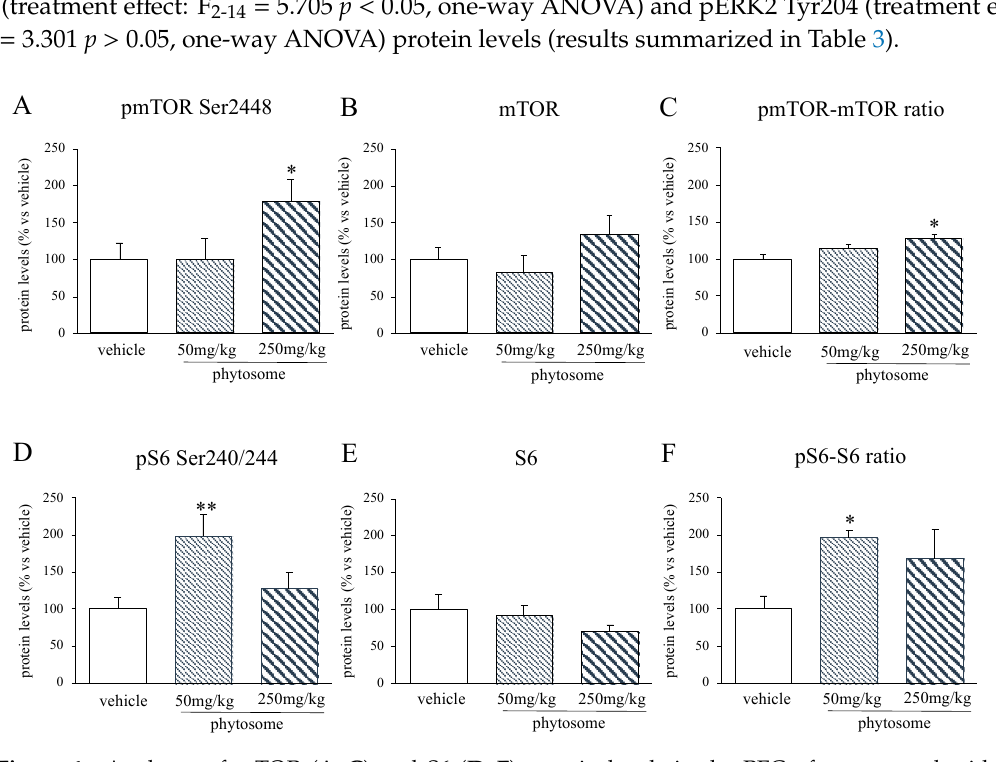
Figure 4. Analyses of mTOR ( A – C ) and S6 ( D – F ) protein levels in the PFC of rats treated with phytosome 50 mg/kg or 250 mg/kg. Data are expressed as percent change of vehicle treated rats and are represented in the histograms graphs as mean ± SEM of 3–6 independent determinations. * p < 0.05, ** p < 0.01 vs. vehicle; one-way ANOVA with Fisher’s PLSD.